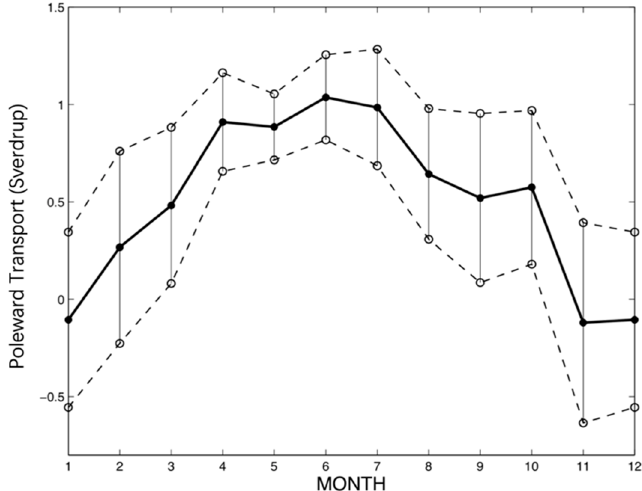
Figure 6. Seasonal variation of the poleward transport through the Bering Strait from the numerical model averaged over 15 years (1990–2004). In oceanography, a Sverdrup is a non-SI (SI stands for “International System of Units”) unit of flow to measure the volumetric rate of the transport of ocean currents, with 1 Sverdrup equal to 1,000,000 m 3 / s .